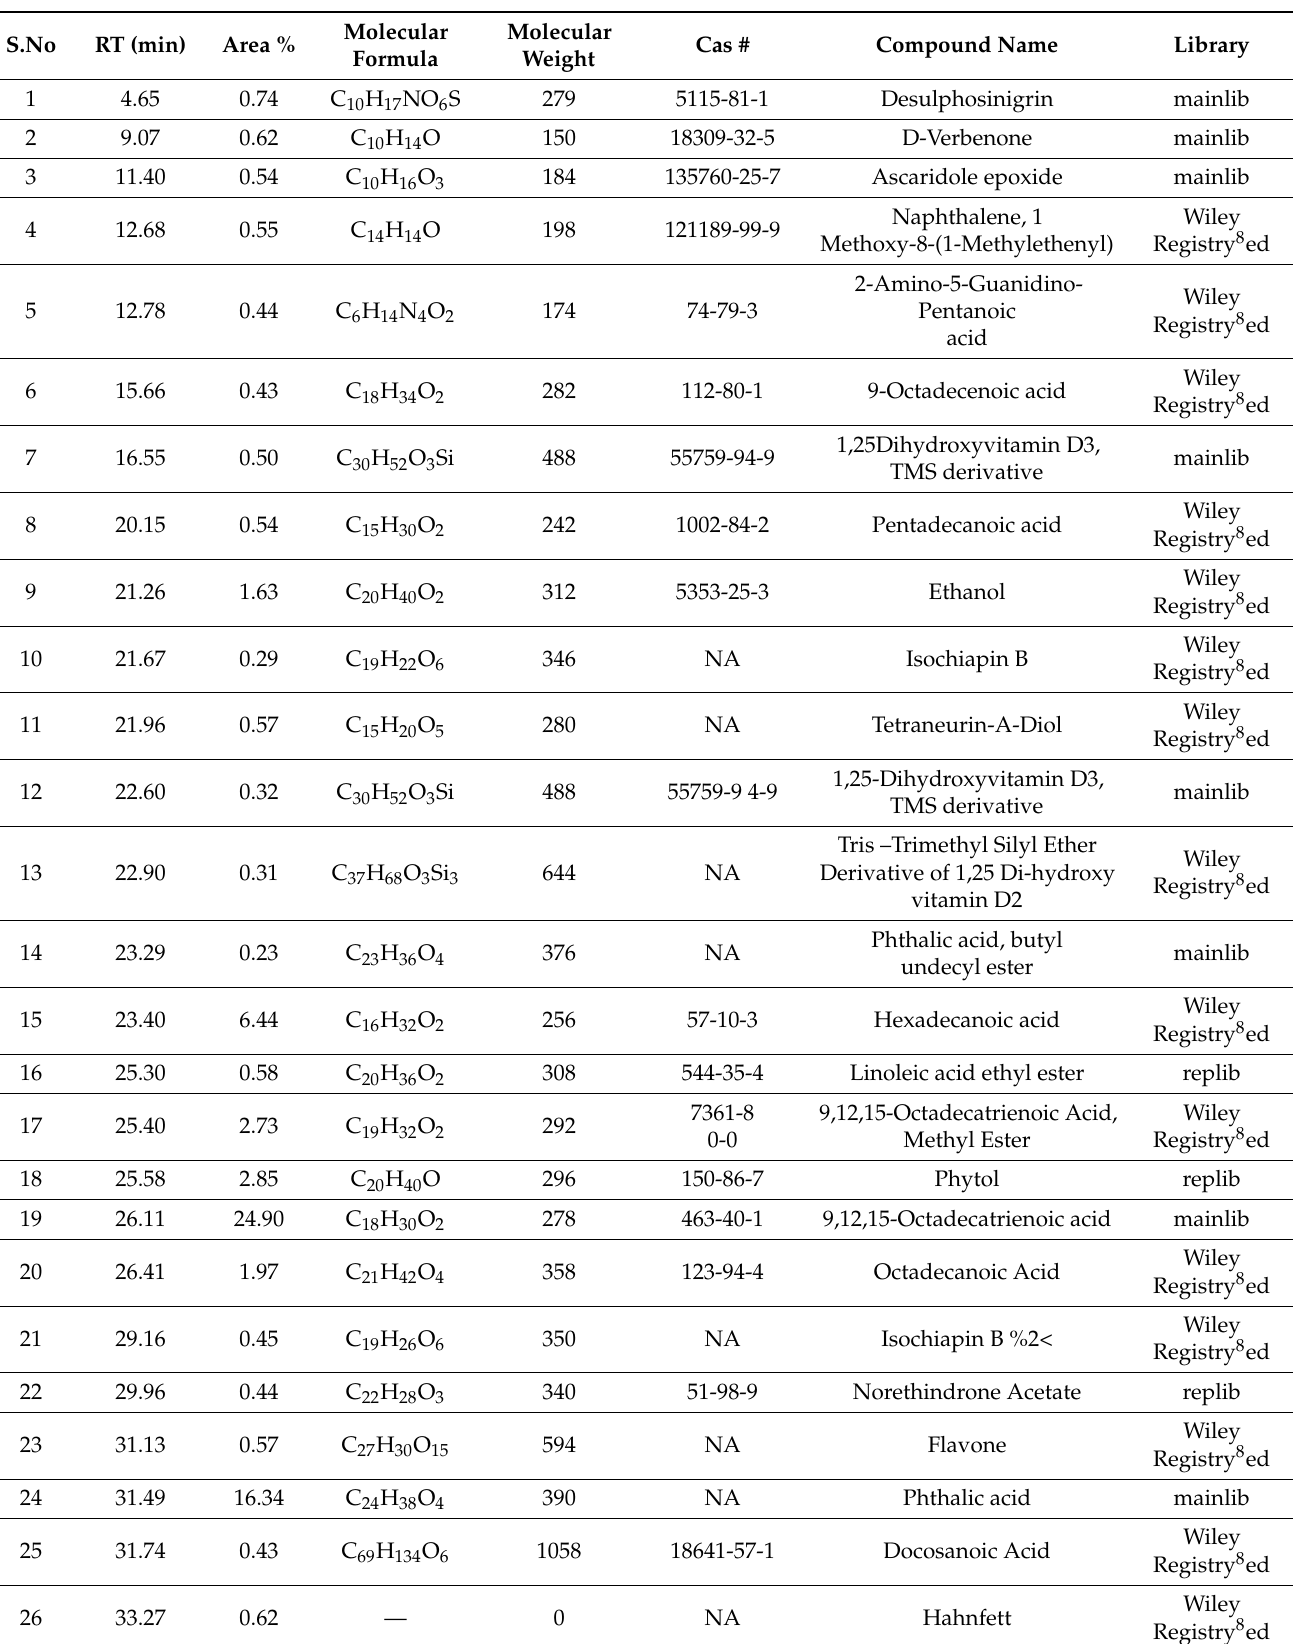
Table 1. Chemical constituents of Wastes of Taif rose extract